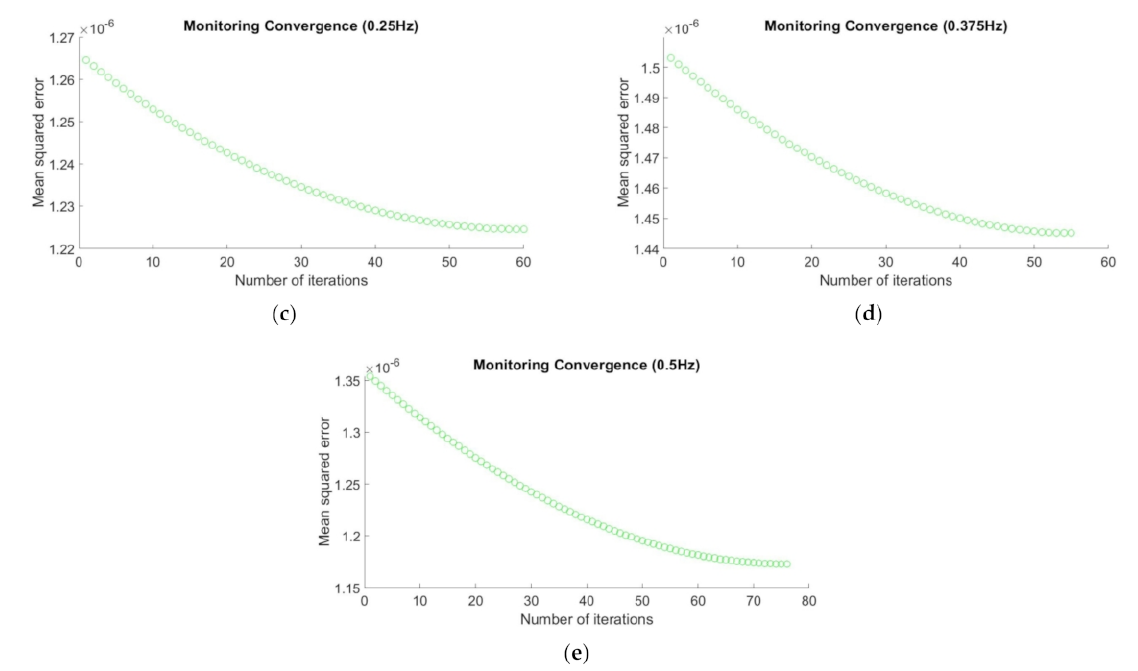
Figure 11. Mean squared error (MSE) versus number of iterations for multiple transmission frequencies (Observational dataset 3 with “unknown” resistivity of 400 Ω m): ( a ) 0.0625 Hz, ( b ) 0.125 Hz, ( c ) 0.25 Hz, ( d ) 0.375 Hz, and ( e ) 0.5 Hz. Table 4. The main stochastic process-based inversion